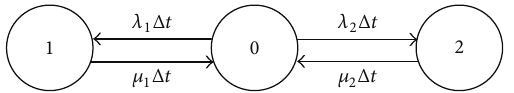
Figure 4: States transition diagram for repairable component with two failure